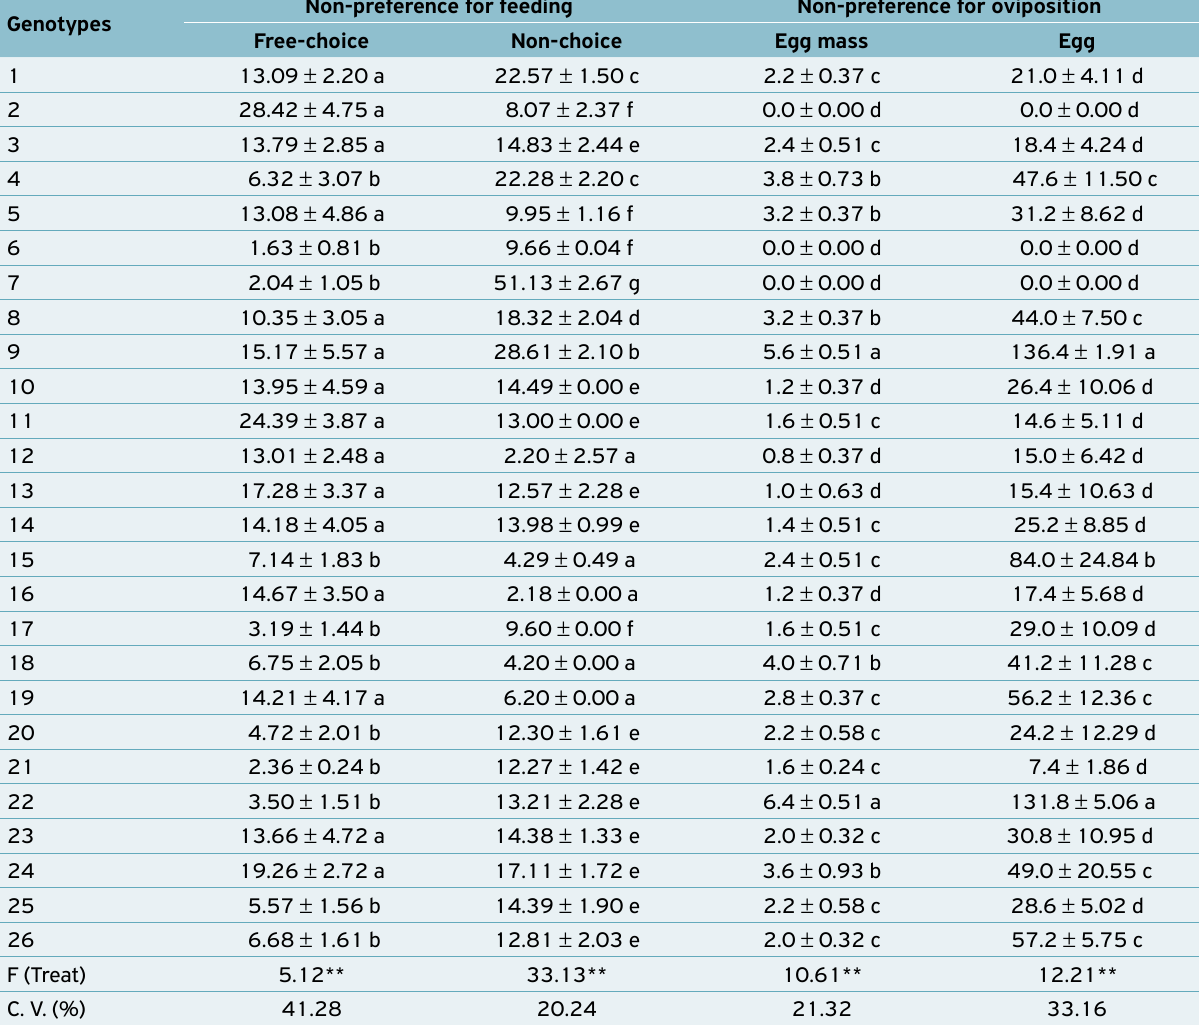
Table 3. Dry weight consumed (mg) of third-instar larvae and oviposition ( ± SE) of Ascia monuste orseis in free- and